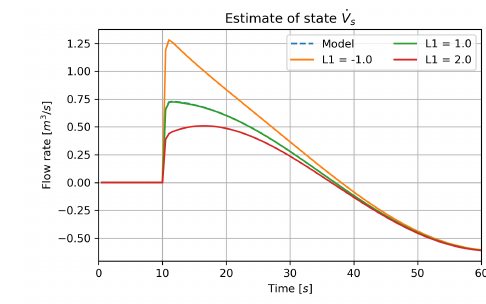
Figure 4: Observer behavior for longer simulation time when only measurement x 1 is injected.